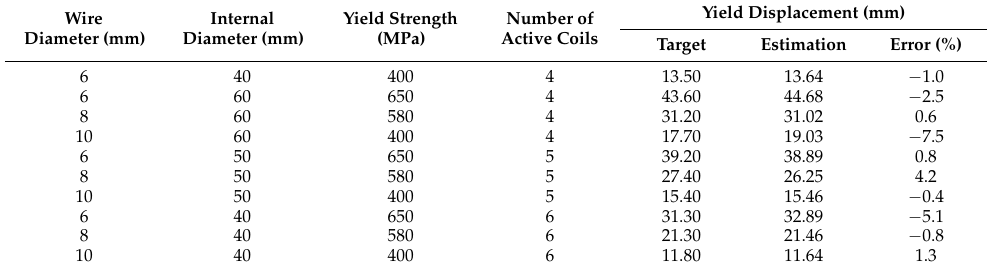
Table 6. Estimated results of